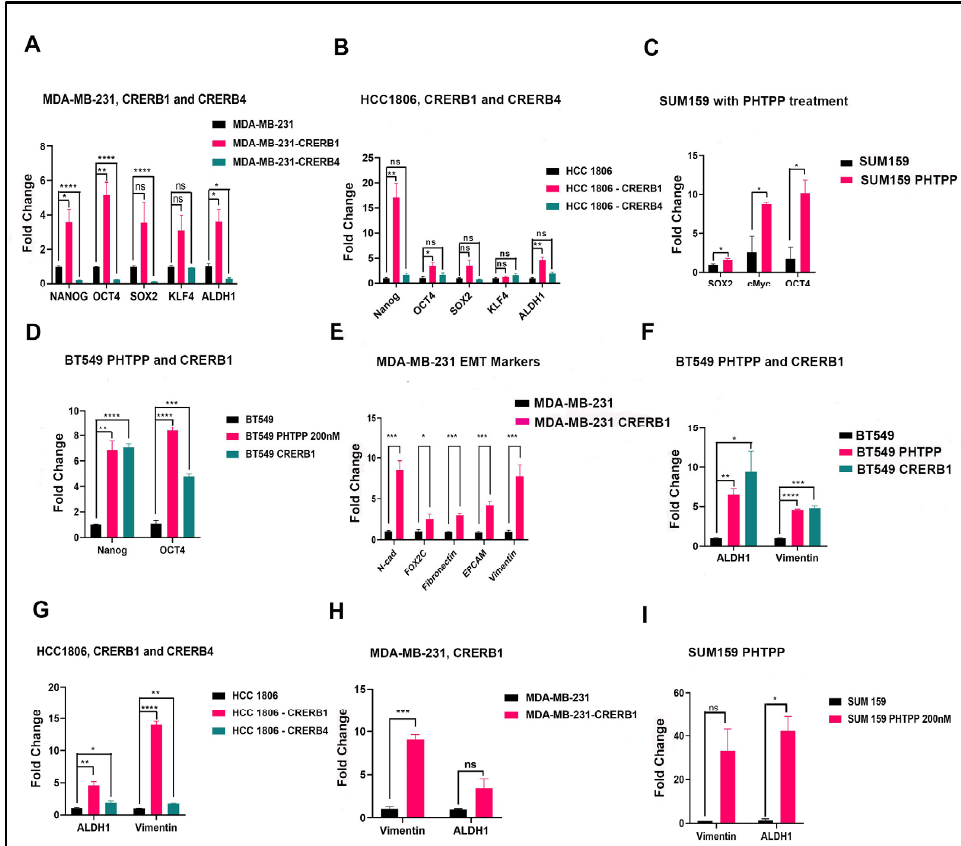
Figure 4. Pluripotency stem cell markers, EMT markers, Vimentin and ALDHA1 are regulated by ER β isoforms. ( A ). qPCR analysis of stem cell markers in MDA-MB-231 cells WT, CRERB1, and CRERB4, ( B ). qPCR analysis of stem cell markers in HCC1806 cells WT, CRERB1, and CRERB4. ( C ). qPCR analysis of stem cell markers in SUM159 cells and PHTPP-treated. ( D ). qPCR analysis of stem cell markers in BT549 cells WT, PHTPP-treated, and CRERB1. ( E ). qPCR analysis of EMT markers in MDA-MB-231 WT and CRERB1. ( F ). qPCR analysis of Vimentin and ALDH1 in BT549 WT, PHTPP, and CRERB1. ( G ). qPCR analysis of Vimentin and ALDH1 in HCC1806 WT, CRERB1, and CRERB4. ( H ). qPCR analysis of Vimentin and ALDH1 in MDA-MB-231 WT and CRERB1. ( I ). qPCR